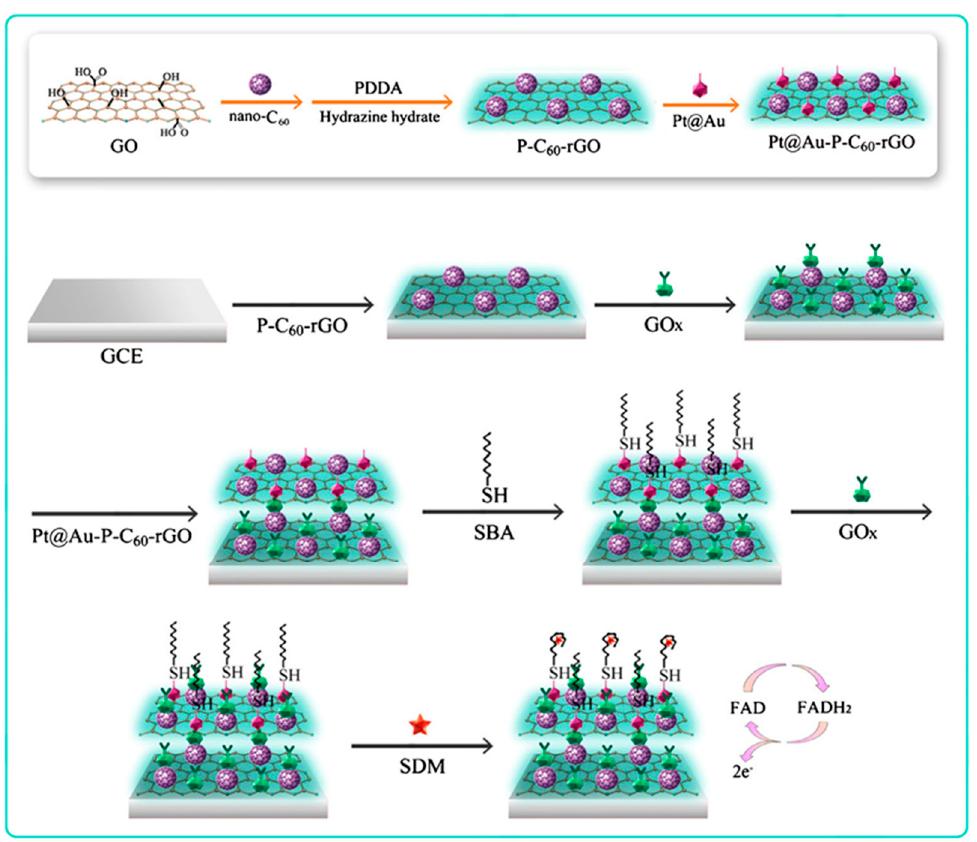
Figure 9. Schematic illustration of the stepwise construction of an aptasensor for the determination of sulfadimethoxine (SDM) using fullerene-doped reduced graphene oxide nanohybrids. Reproduced from [118] with permission.